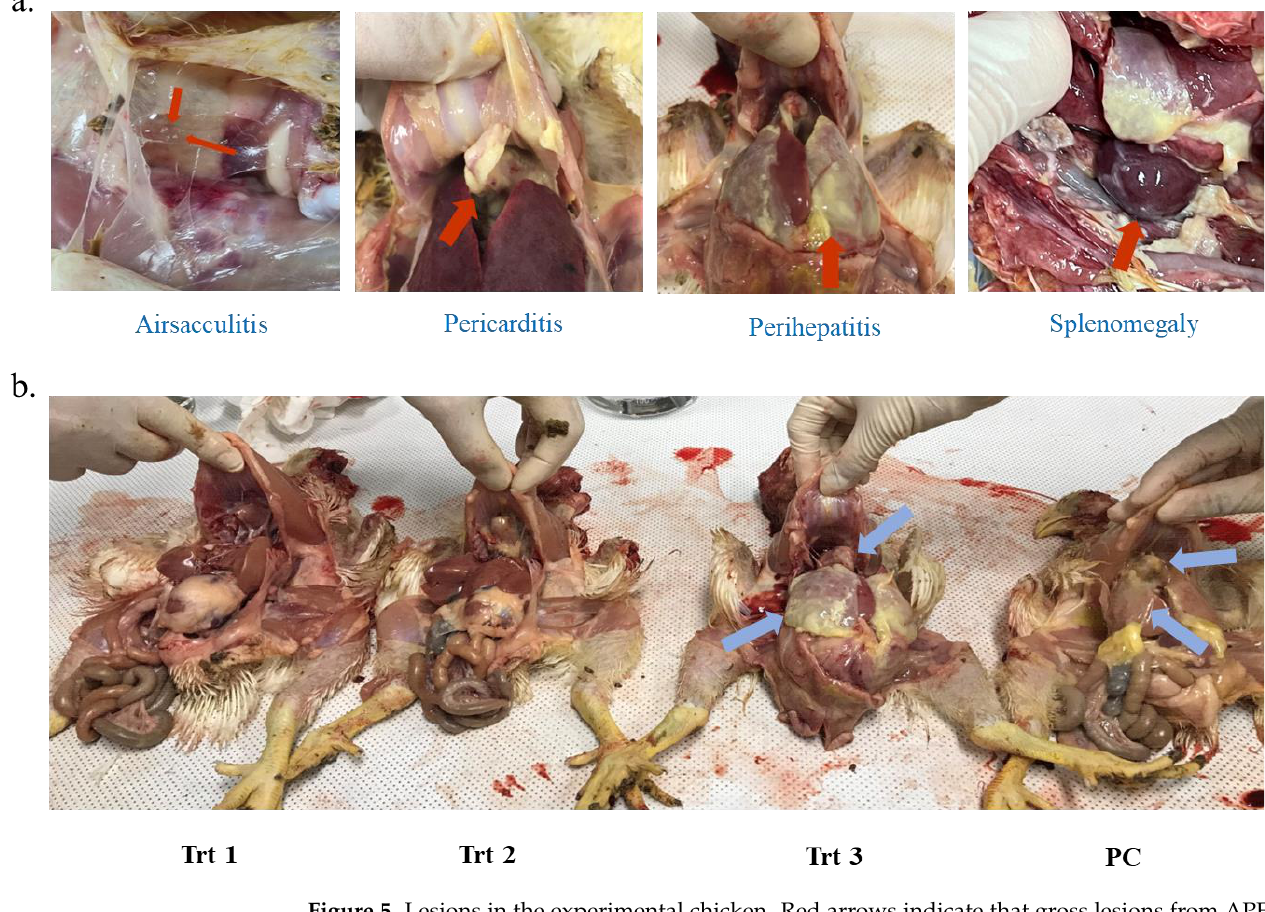
Figure 5. Lesions in the experimental chicken. Red arrows indicate that gross lesions from APEC- afflicted layers with airsacculitis, pericarditis, perihepatitis, and splenomegaly are presented ( a ). Blue arrows show that severe pericarditis and perihepatitis occurred in the Trt 3 and PC groups, whereas there were no symptoms in the Trt 1 and Trt 2 groups ( b ). Table 2. Data for the lesions and mortality rates by APEC in experimental layers.